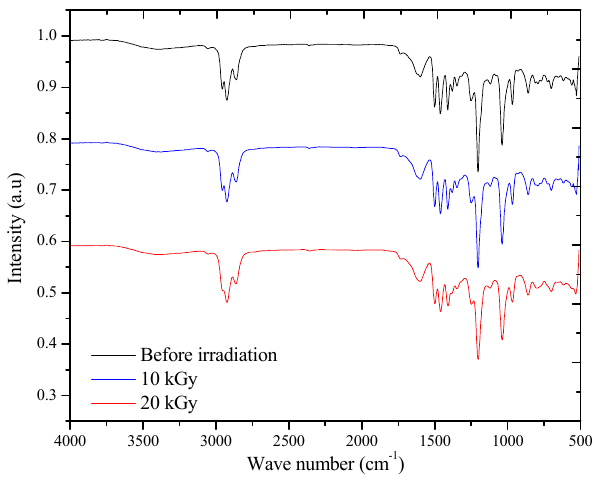
Figure 9. FT-IR spectra of the BEHP- co -MEH–PPV (BMP) samples pre- and post-irradiation at a 20 µ M concentration.